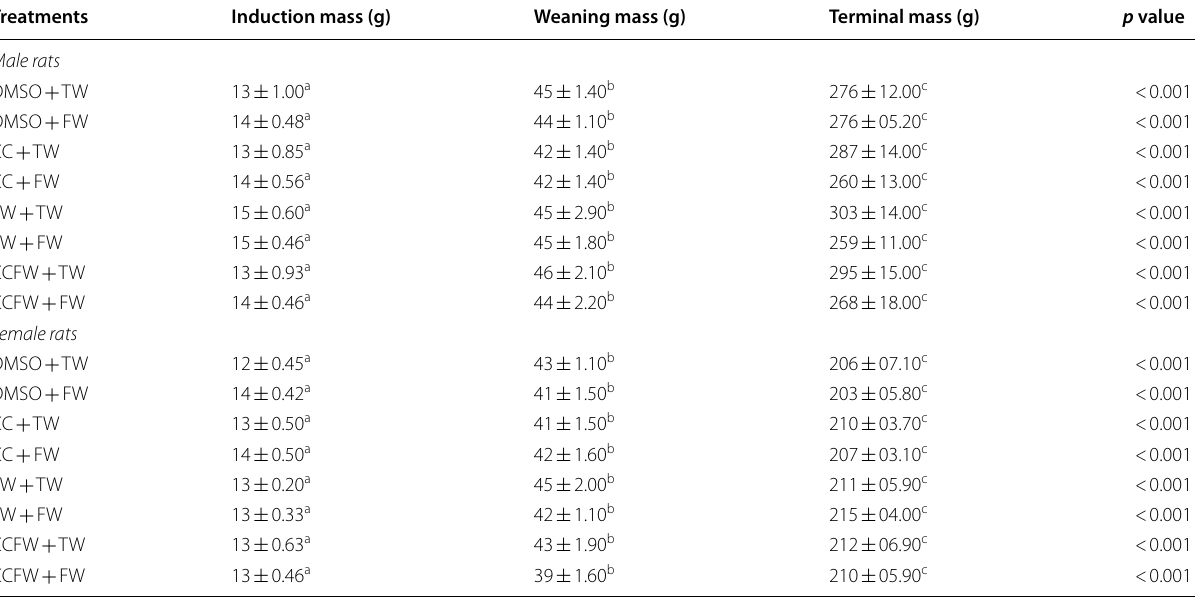
Table 1 Growth pattern comparison across experimental groups with high fructose and curcumin treatment of male and female Sprague-Dawley rats (from post-natal day 6 to